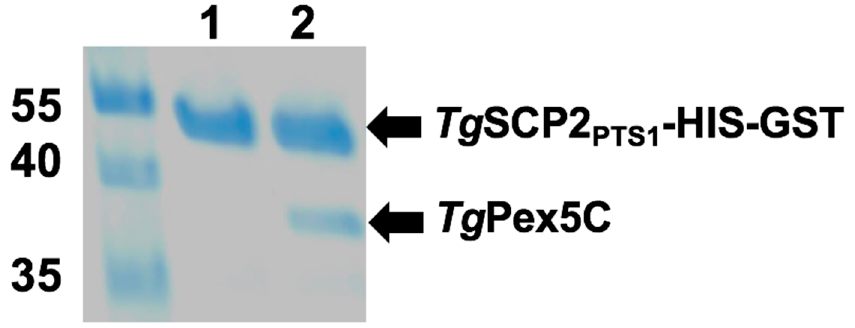
Figure 6. Interaction of Tg SCP2 PTS1 and Tg PEX5C in vitro . Pull-down assay was performed using the bait Tg SCP2 PTS1 with a HIS-GST tag. Eluates of the pull-down without prey protein (Lane 1, negative control) and Tg PEX5C (Lane 2) are shown. Molecular weight markers are in kilodaltons.